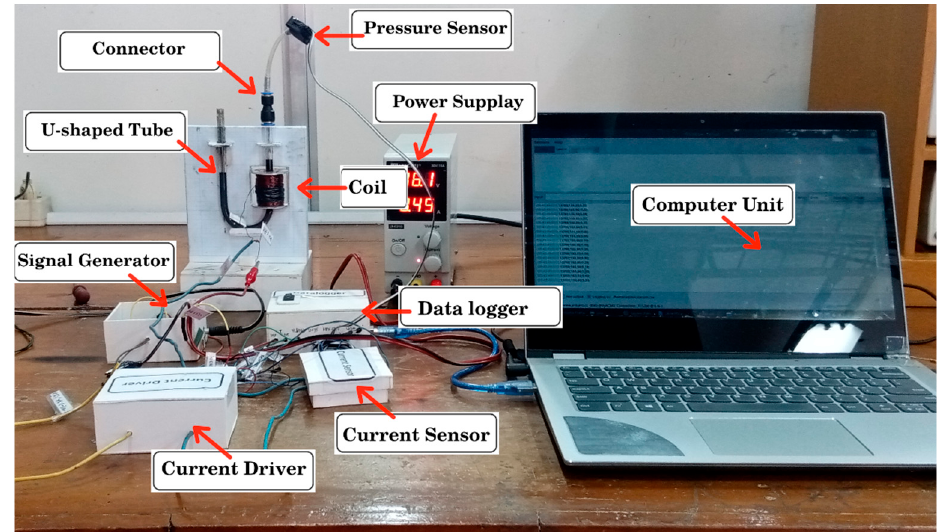
Figure 3. An experimental apparatus for the pressure measurement.